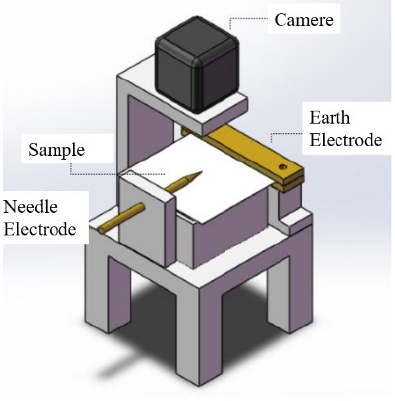
Figure 13. High-frequency surface discharge experimental system. The flashover voltage was measured, and the sample was pressurized at the rate of 0.2 kV/s until surface flashover, which was recorded as flashover voltage. The surface discharge life was measured under the condition of applying the high-frequency sinusoidal voltages of 11 kV and 20 kHz. The time from pressurization to film breakdown was recorded; this is defined as the creeping discharge life. The flashover voltage and lifetime of the samples were characterized by Weibull distribution, as shown in Figure 14.